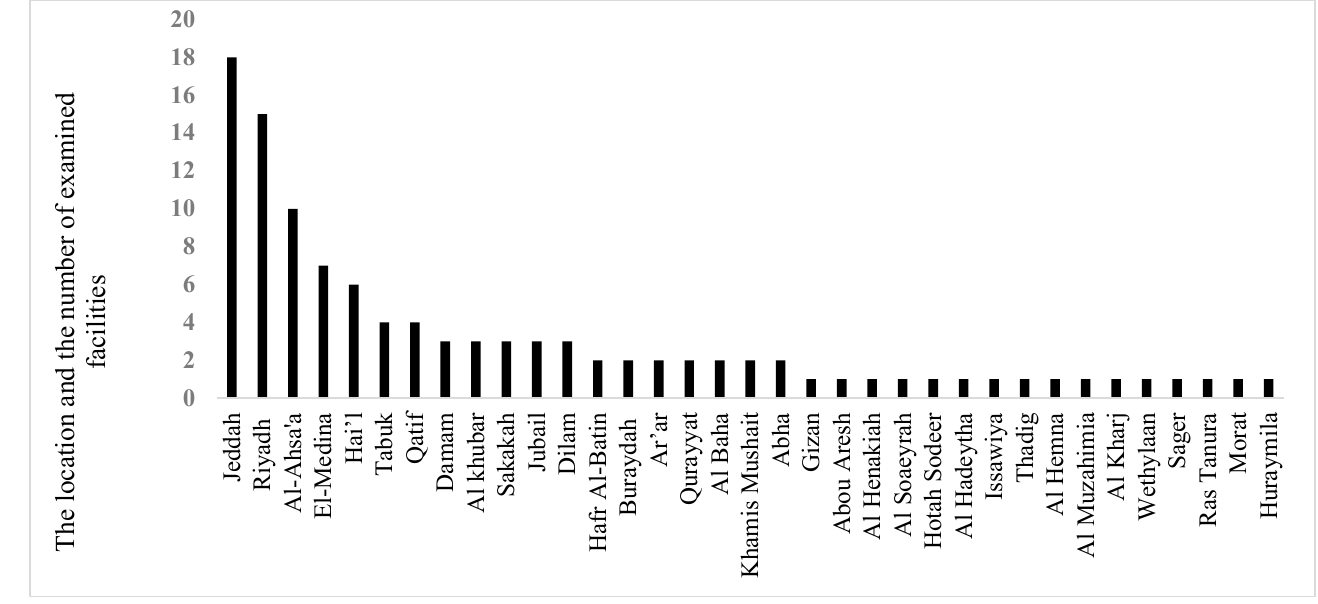
Figure 1. The location and the number of examined diagnostic X-ray facilities selected in the site visit at KSA governorates.